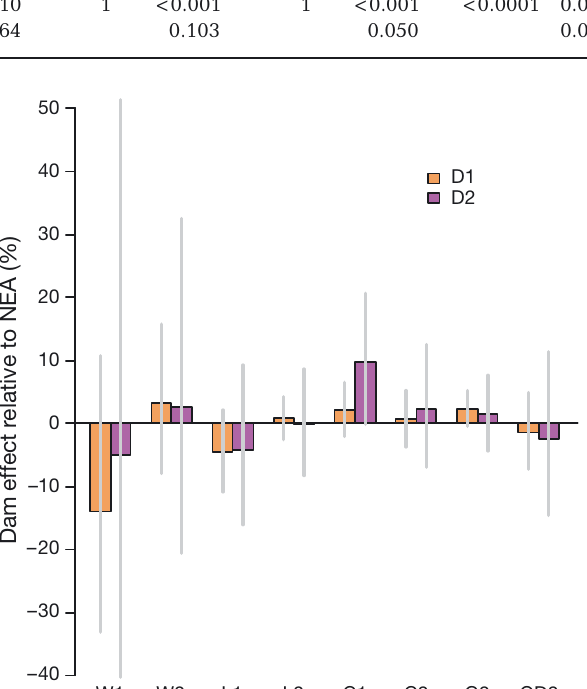
Fig. 3. Modeled effect of cod dam group on different meas- ures taken at end of Phases I and II of Expt A. The dam effects for broodstock groups D1 and D2 are given as a per- centage relative to the wild Northeast Arctic (NEA) group. Error bars show 95% confidence limits. See Table 2 for further description of modeling results. W: weight; L: length; C: condition factor; G: specific growth rate; OD: oocyte diameter; 1,2: Phase